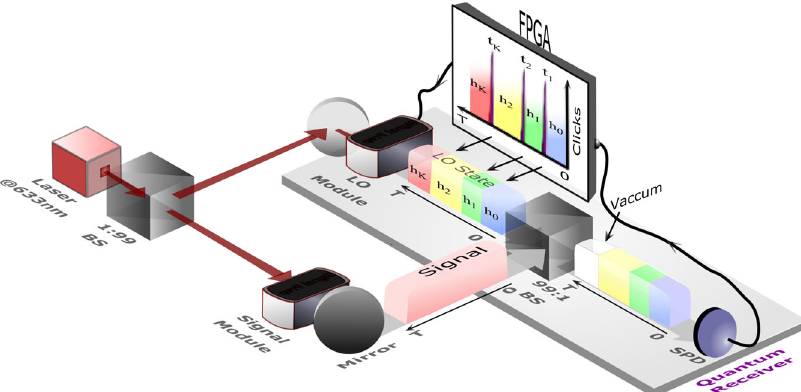
Fig. 3 The experimental implementation of our time resolved quantum receiver testbed. The input signal is prepared with an acousto- optic modulator (AOM) and linear optics (shown as the signal module). The quantum receiver, highlighted with the shaded rectangle, is comprised of the AOM-based LO preparation stage (shown as the LO module), a 99:1 beam splitter, an SPD, and an FPGA. The electronic output of the SPD is connected to the FPGA that implements the discrimination strategy. The color of the rectangle representing the input signal demonstrates a particular state of the fi eld, the colors of the rectangle representing the LO beam demonstrate hypotheses that change with each photon detection, and the colors of the rectangle representing the displaced beam demonstrate the changes in the displaced signal; the vacuum state is shown in white. The inset demonstrates the real-time Bayesian feedback algorithm, that timestamps photon detections t 1 … t K and determines best hypothesis h 0 … h K . T - duration of the input